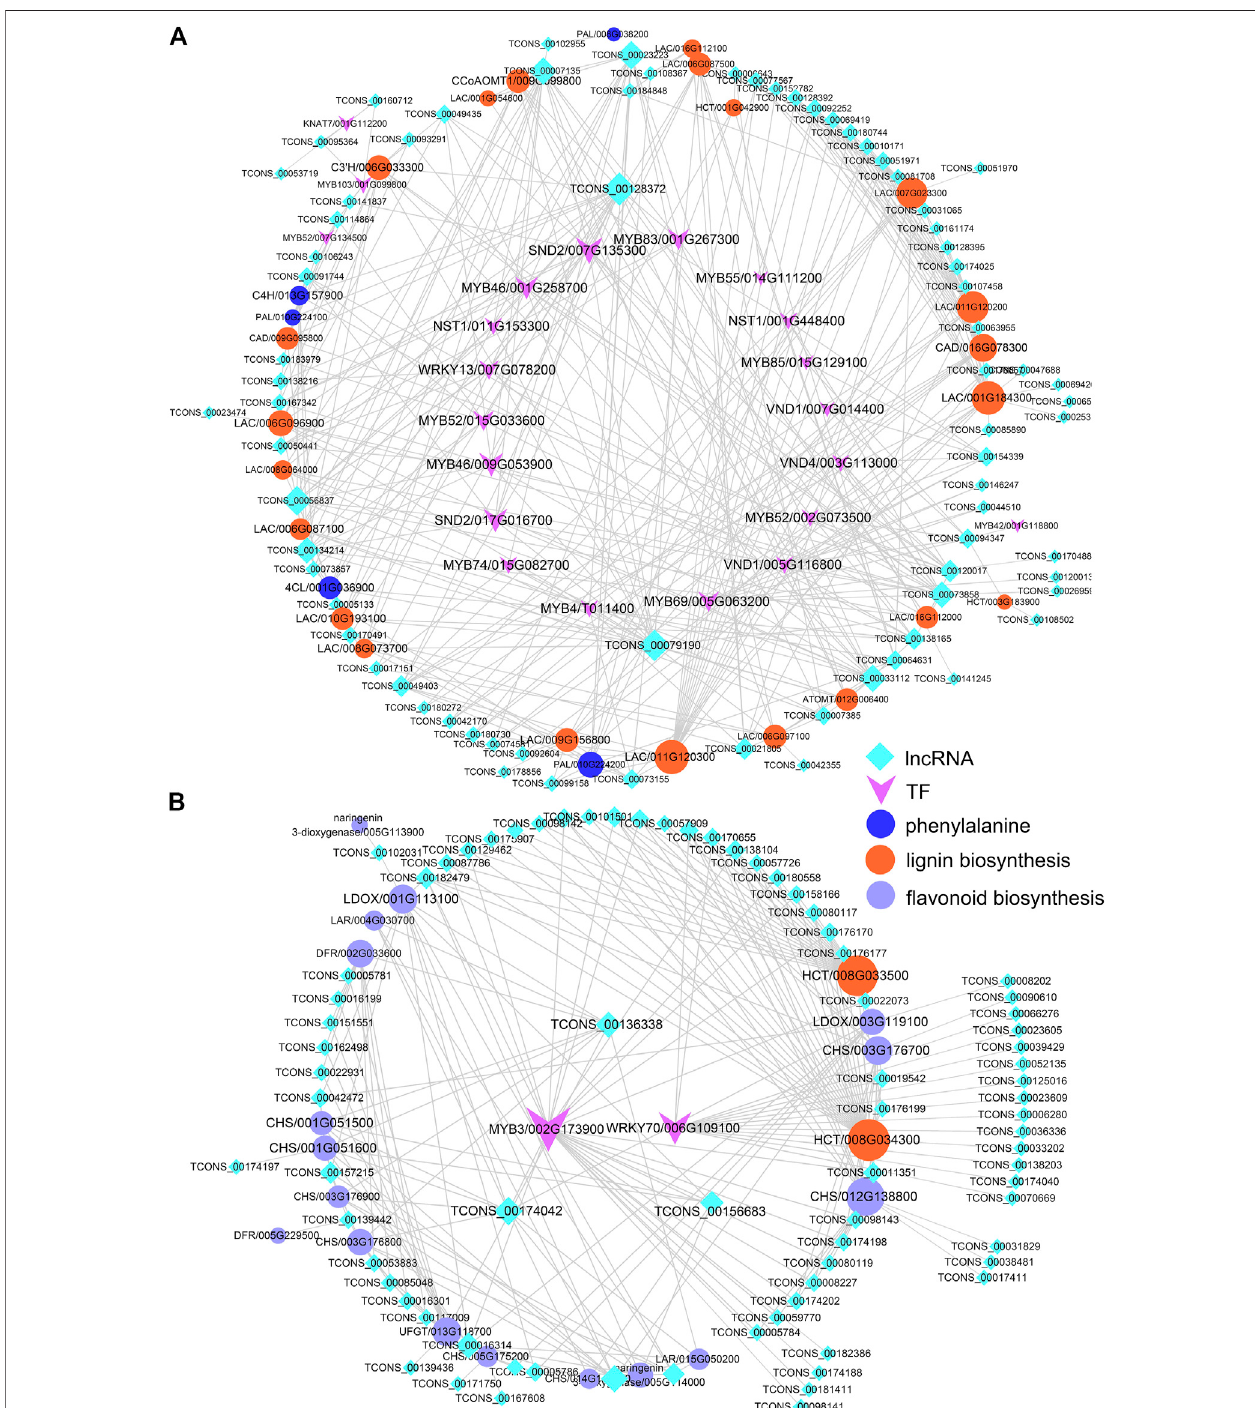
FIGURE 5 | Interaction network diagrams. Interaction networks of differentially expressed lncRNAs, DEmRNAs, and transcription factors (TFs) of phenylalanine biosynthesis, including lignin (A) and fl avonoid (B) biosynthesis.